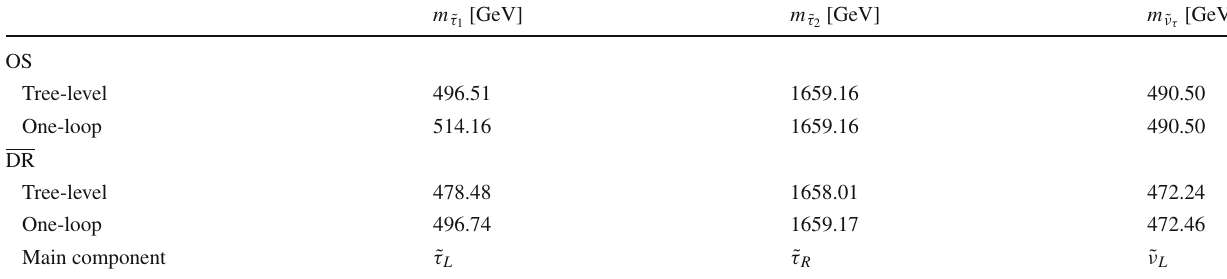
Table 4 The tree-level and one-loop corrected stau and tau sneutrino masses in the DR and the OS